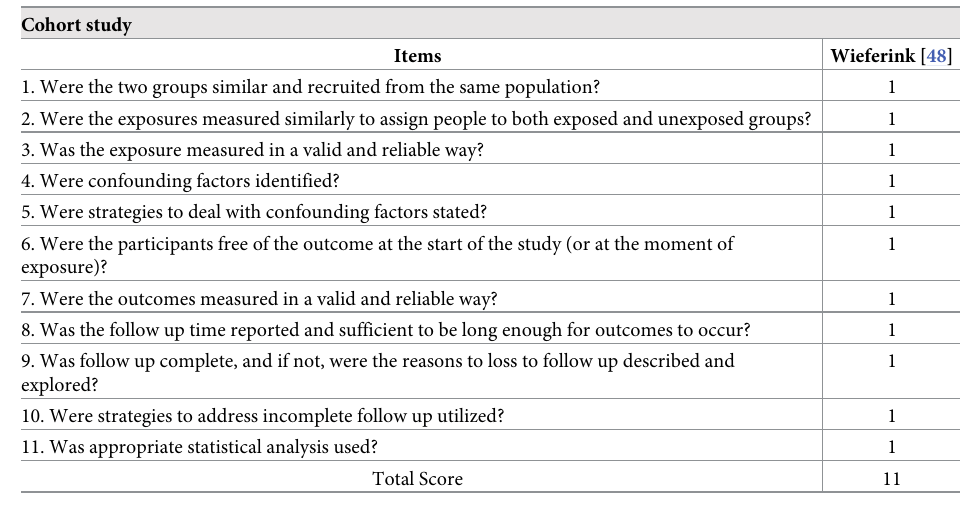
Table 4. Study quality ratings for cohort